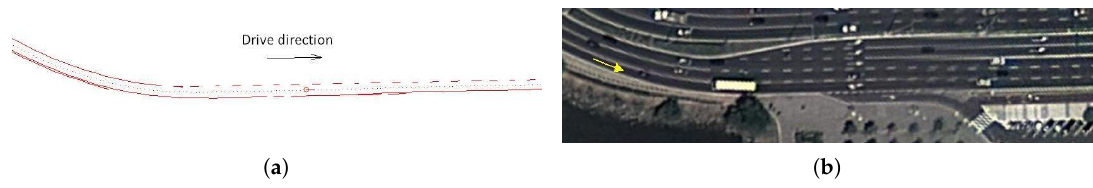
Figure 3. Example of map build by the MAP/ back lane mark registry (BLMR) builder module: ( a ) the built lane marking map; ( b ) satellite image of the corresponding road section.